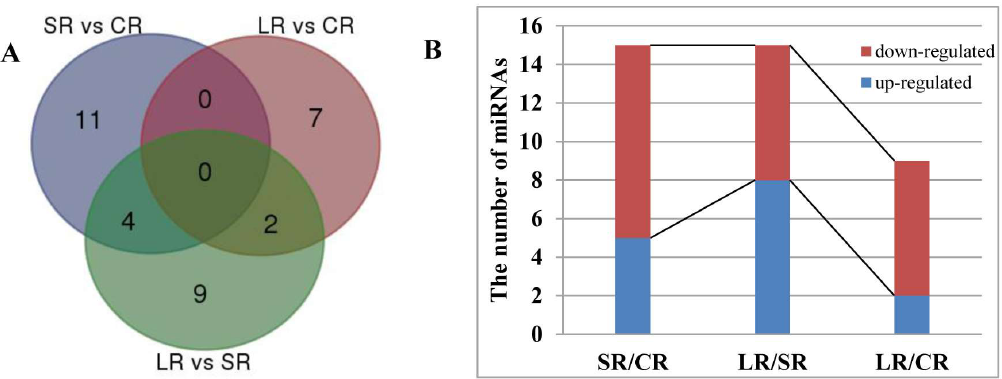
Figure 6. Significant differentially expressed miRNAs by ABA treatment in the roots of P. euphratica . ( A ) Venn diagram of significantly differentially expressed miRNAs by ABA in the roots. ( B ) The number of up- or downregulated miRNAs following ABA treatment in the roots.